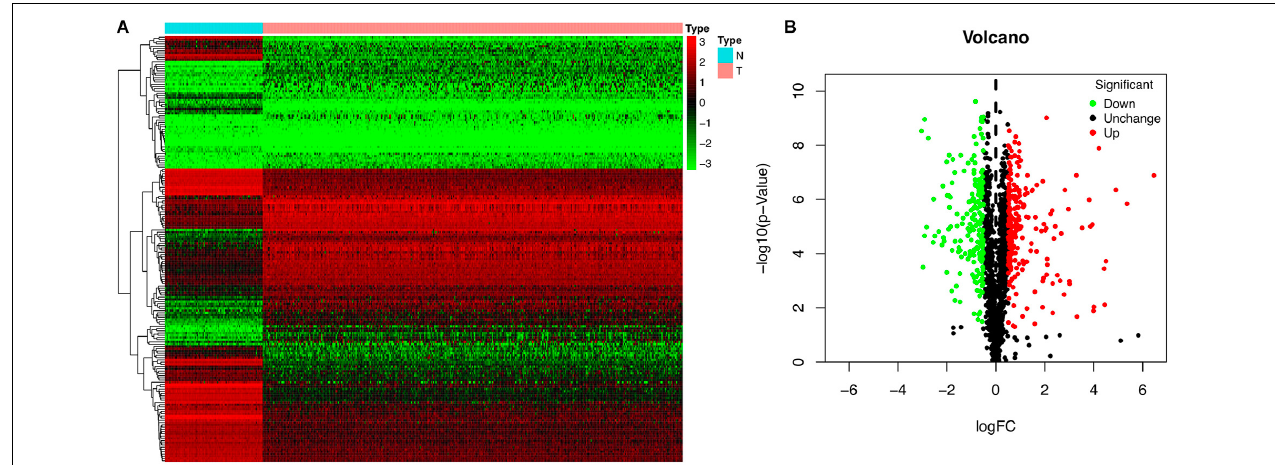
FIGURE 2 | Differentially expressed RBPs in OSC. (A) Heat map. (B) Volcano